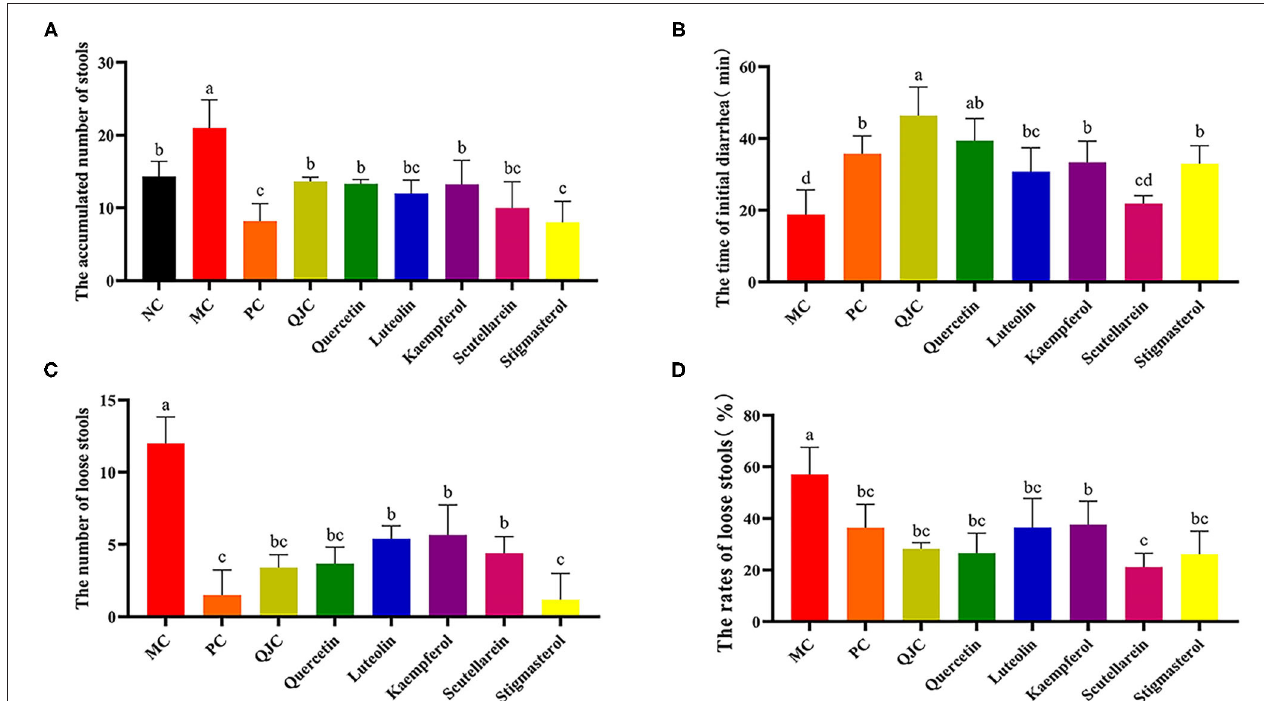
FIGURE 7 | Treatment of diarrhea mice with QJC and its five active ingredients. Data were expressed as the mean ± SD ( n = 5); the significant difference between groups ( p < 0.05) was shown by the different letters above the histogram. (A) The accumulated number of stools. (B) The time of initial diarrhea. (C) The number of loose stools. (D) The rates of loose